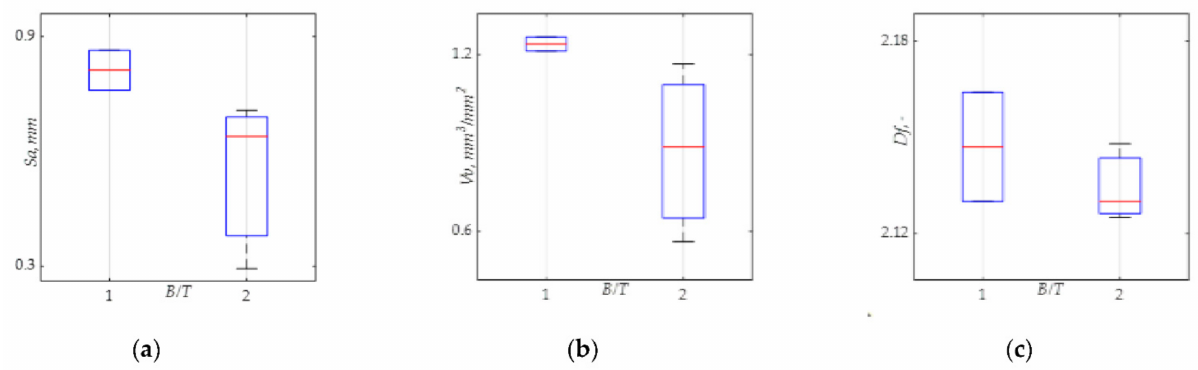
Figure 12. Boxplot for: ( a ) arithmetical mean height Sa , and ( b ) void volume Vv parameters, ( c ) fractal dimension Df